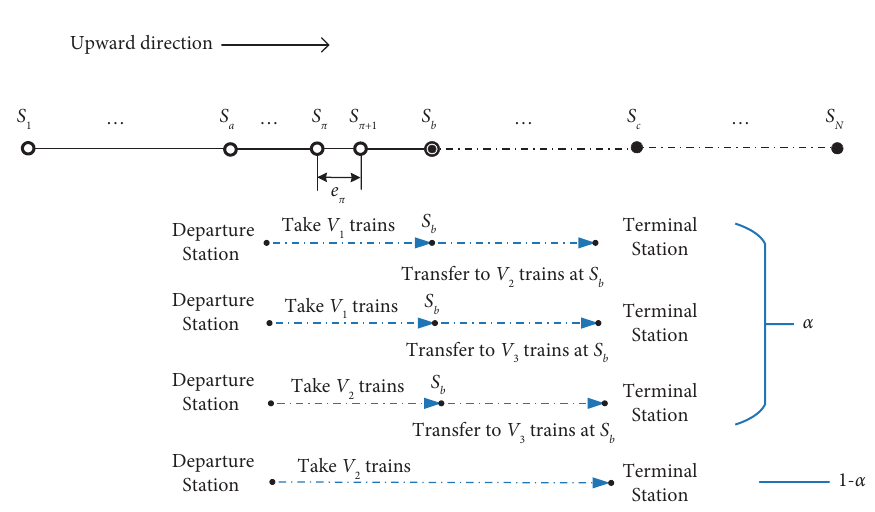
Figure 7: Travel scheme of type 23 passenger flows.